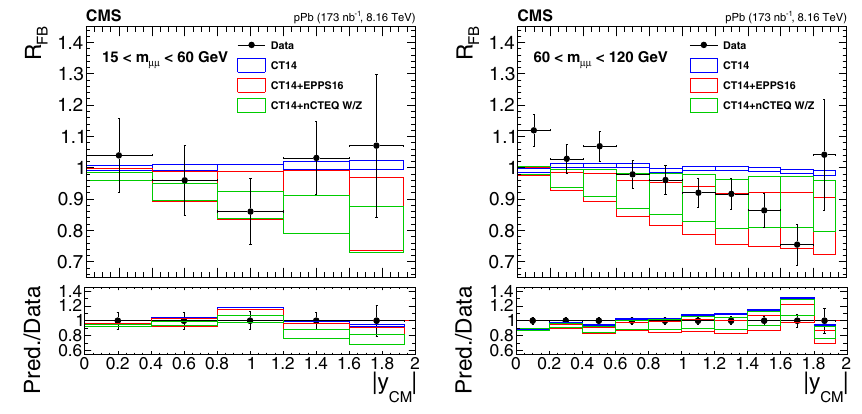
Figure 2. Forward-backward ratios for 15 – 60 GeV (left) and 60 – 120 GeV (right). The verti- cal error bars on the data points represent the quadratic sum of the statistical and systematic uncer- tainties. The theory predictions from the CT14 [12] proton PDF (blue), CT14 + EPPS16 [3] (red), or CT14 + nCTEQ15WZ [4] (green) nPDF sets. The boxes show the 68% confidence level (n)PDF uncer- tainty in these predictions. The ratios of predictions over data are shown in the lower panels, where the data and the (n)PDF uncertainties are shown separately, as error bars around one and as coloured boxes,